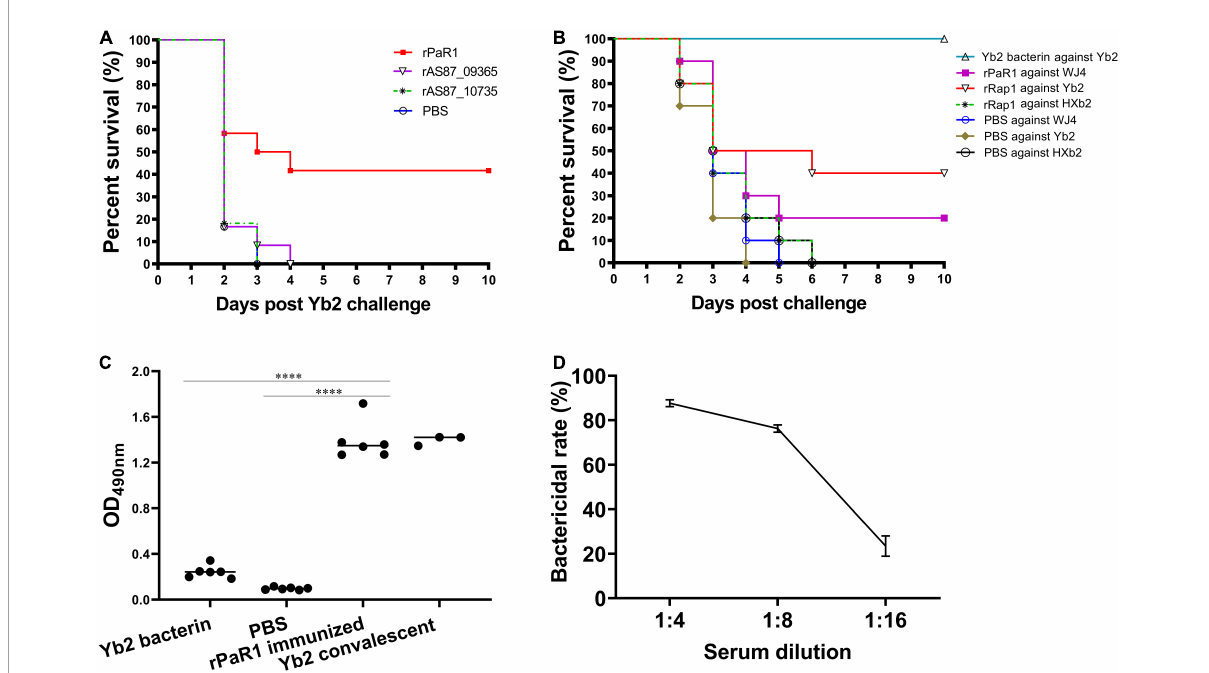
FIGURE2 Recombinant protein recombinant PaR1 (rPaR1) confers protective immunity against Yb2 challenge. (A) Recombinant protein rPaR1, but not rAS87_RS09020 or rAS87_RS09965, conferred protective immunity against Yb2 challenge. (B) Recombinant protein rPaR1 conferred protective immunity against challenge with serotype 2 R. anatipestifer strain Yb2, but not serotype 1 strain WJ4 or serotype 10 strain HXb2. (C) ELISA scatter plots of antibodies to PaR1 detected in duck sera. Ducklings immunized with rPaR1, but not those immunized with inactivated Yb2 bacterin, displayed high levels of anti-PaR1 antibodies in their sera. Asterisks indicate statistically significant differences between two groups ( ∗∗∗∗ < 0.0001). (D) Bactericidal activity of rabbit serum against rPaR1. Rabbit antiserum against rPaR1 and naïve rabbit serum were inactivated at 56 ◦ C for 30 min and 2-fold serial diluted in PBS. Then the bactericidal activity against serotype 2 strain Yb2 was performed. The highest serum dilution causing 50% killing was expressed as the bactericidal